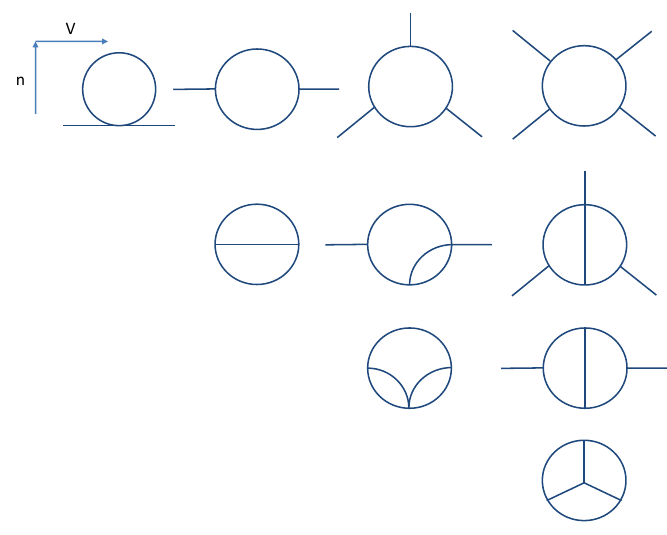
Figure 1 . Hierarchy of diagrams according to edge contraction. Each column has diagrams of (cid:12)xed number of vertices so that necessary sources for each diagram are always on its left. The propagator seagull is on the third column from the left, second from